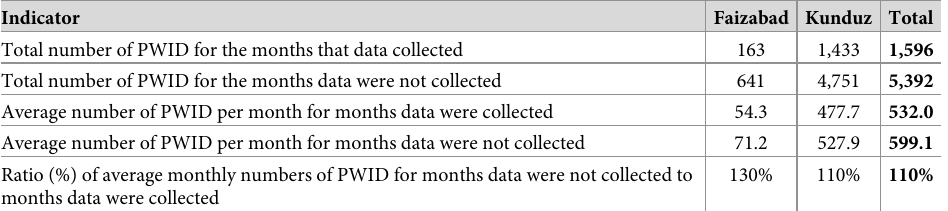
Table 4. Adjustment factor for seasonality (winter) for the population size estimation of people who inject drugs (PWID), Afghanistan, 2019.